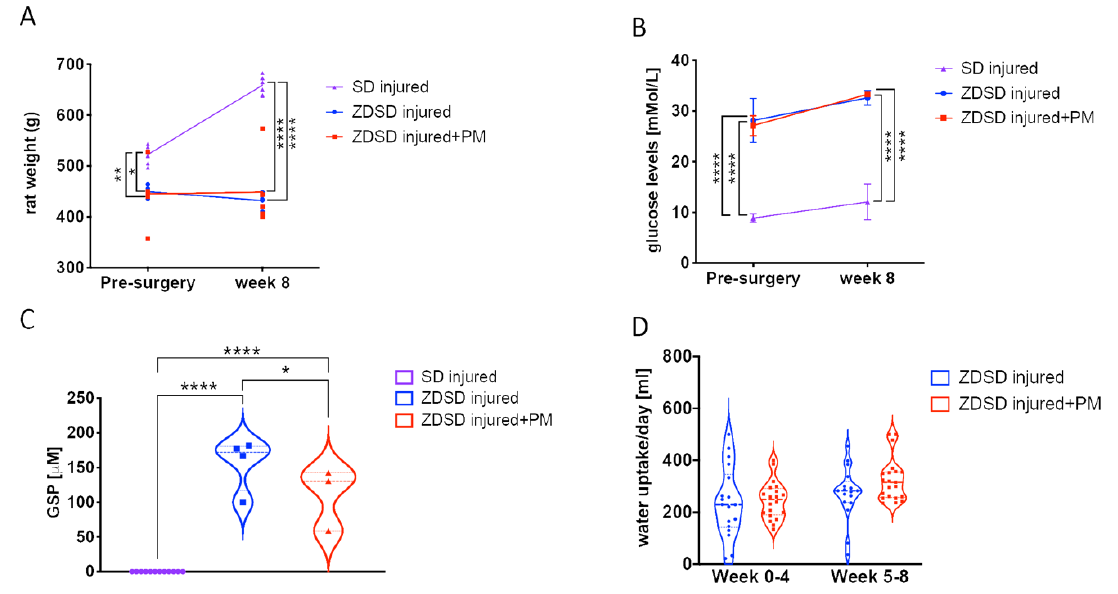
Figure1. PMtreatmentresultsinreductionofGSPlevelsinZDSDratswithinjuredIVDs. ( A ) Rat weight measurements ( n ≥ 5), ( B ) blood glucose testing (n ≥ 4), ( C ) the detection of GSP ( n ≥ 5) and ( D ) daily Figure 1. PM treatment results in reduction of GSP levels in ZDSD rats with injured IVDs. ( A ) Rat water uptake of the various experimental groups at di ff erent time points ( n ≥ 5). GSP: glycated serum weight measurements ( n ≥ 5 ), ( B ) blood glucose testing (n ≥ 4 ), ( C ) the detection of GSP ( n ≥ 5 ) and ( D ) protein. * p < 0.05, ** p < 0.01, **** p < daily water uptake of the various experimental groups at different time points ( n ≥ 5 ). GSP: glycated serum protein. * p < 0.05, ** p < 0.01, **** p < 0.0001.